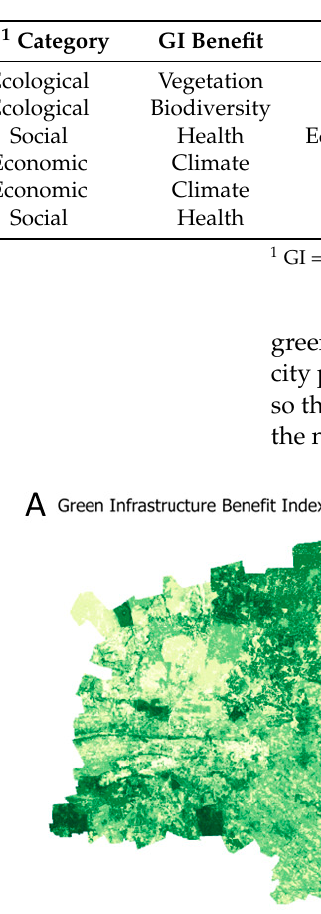
Figure 5. Differences between the means and spread of the measured green infrastructure benefit in the City of Tshwane, summarized by the land cover classes categorized in existing decision tools: Gauteng Biodiversity and Conservation Plan (C-Plan), and Climate Risk and Vulnerability Assess- ment (CRVA), which prioritize biodiversity protection and climate resilience, respectively. We found that areas that scored low on the multifunctional benefit scale coincided with the city core and informal settlements. Informal settlements tend to be areas of high- density dwelling, supporting up to 160 dwelling units per hectare [61]. These areas scored